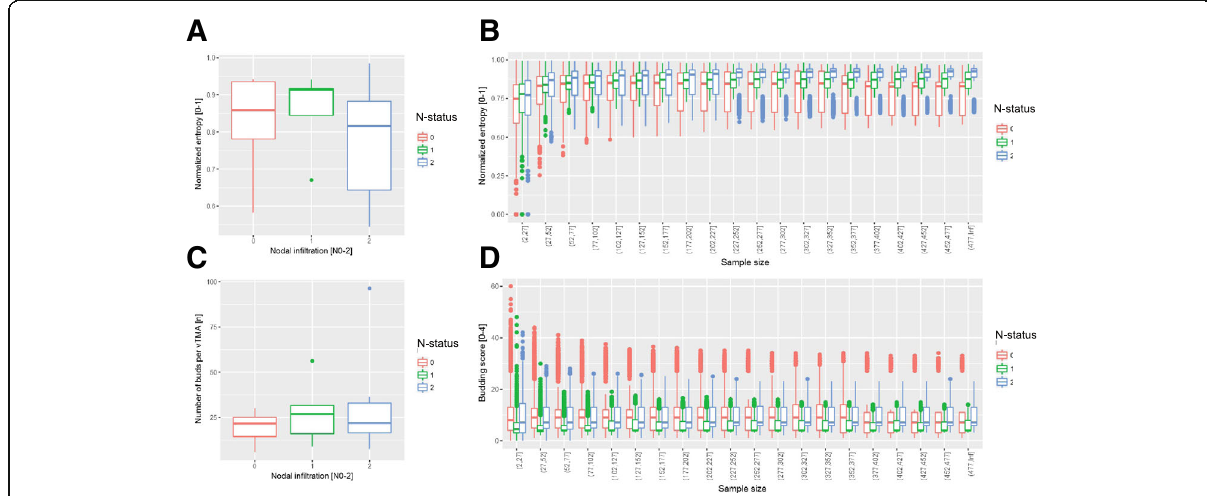
Fig. 5 Monte Carlo-like simulation. From every case (of the 20 cases with 290 ± 152 vTMAs from the tumor border) repetitively a predefined number of vTMAs were chosen at random, and subsequently the median number of buds, the median budding score and the normalized entropy were calculated. This process was repeated several times ( n = 10) with different sample sizes (from n = 2 to n = 200). a and c show the normalized entropy and the median number of tumor buds in relation to the sample size, respectively. b and d show the normalized entropy and the median number of tumor buds for the complete tumor border,